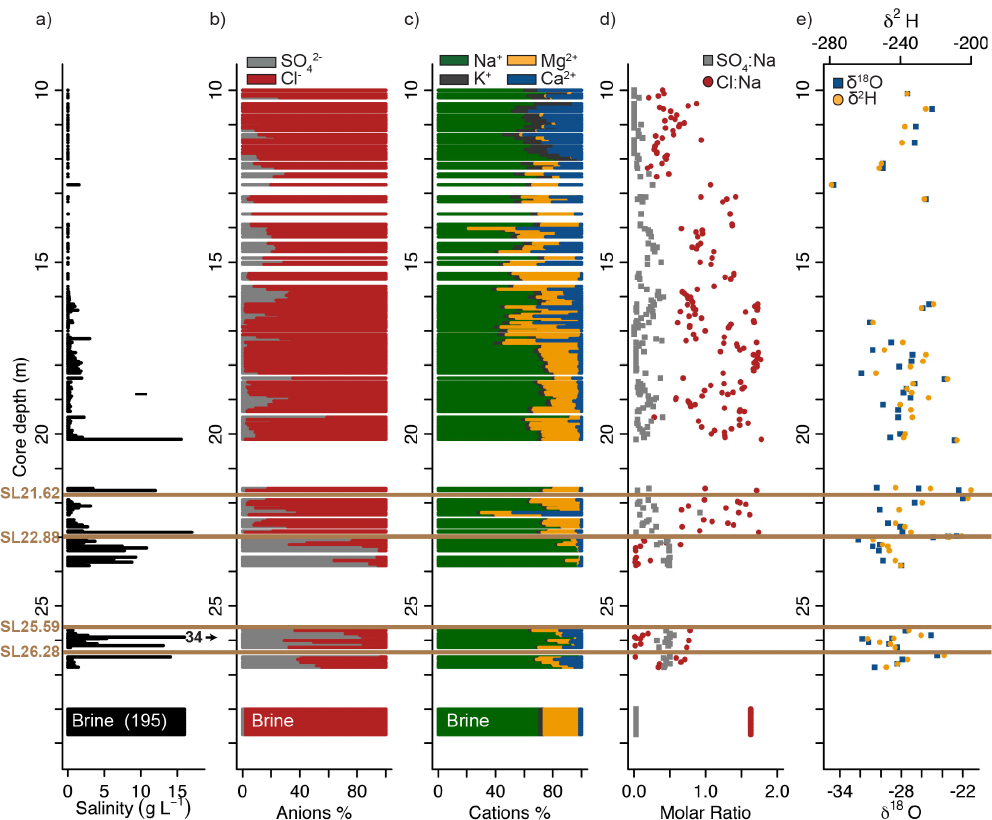
Figure 2. (a) Salinity of ice samples below 10m subsampled from the Lake Vida ice cores. Salinities ranged from < 1 to 34gL − 1 . Brine salinity is 195gL − 1 . SL21.62, SL22.88, SL25.59, and SL26.28 represent sediment layers > 10cm thick present in the 27m ice core. (b, c) Total percentage of major anions and cations. Ion percentages in the brine are noted at the base of the figure. (c) Ratio of Na + :Cl − and Na + :SO 2 − (mol:mol). (d) Stable isotope composition ( δ 2 H and δ 18 O) of ice samples and sediment pore 4